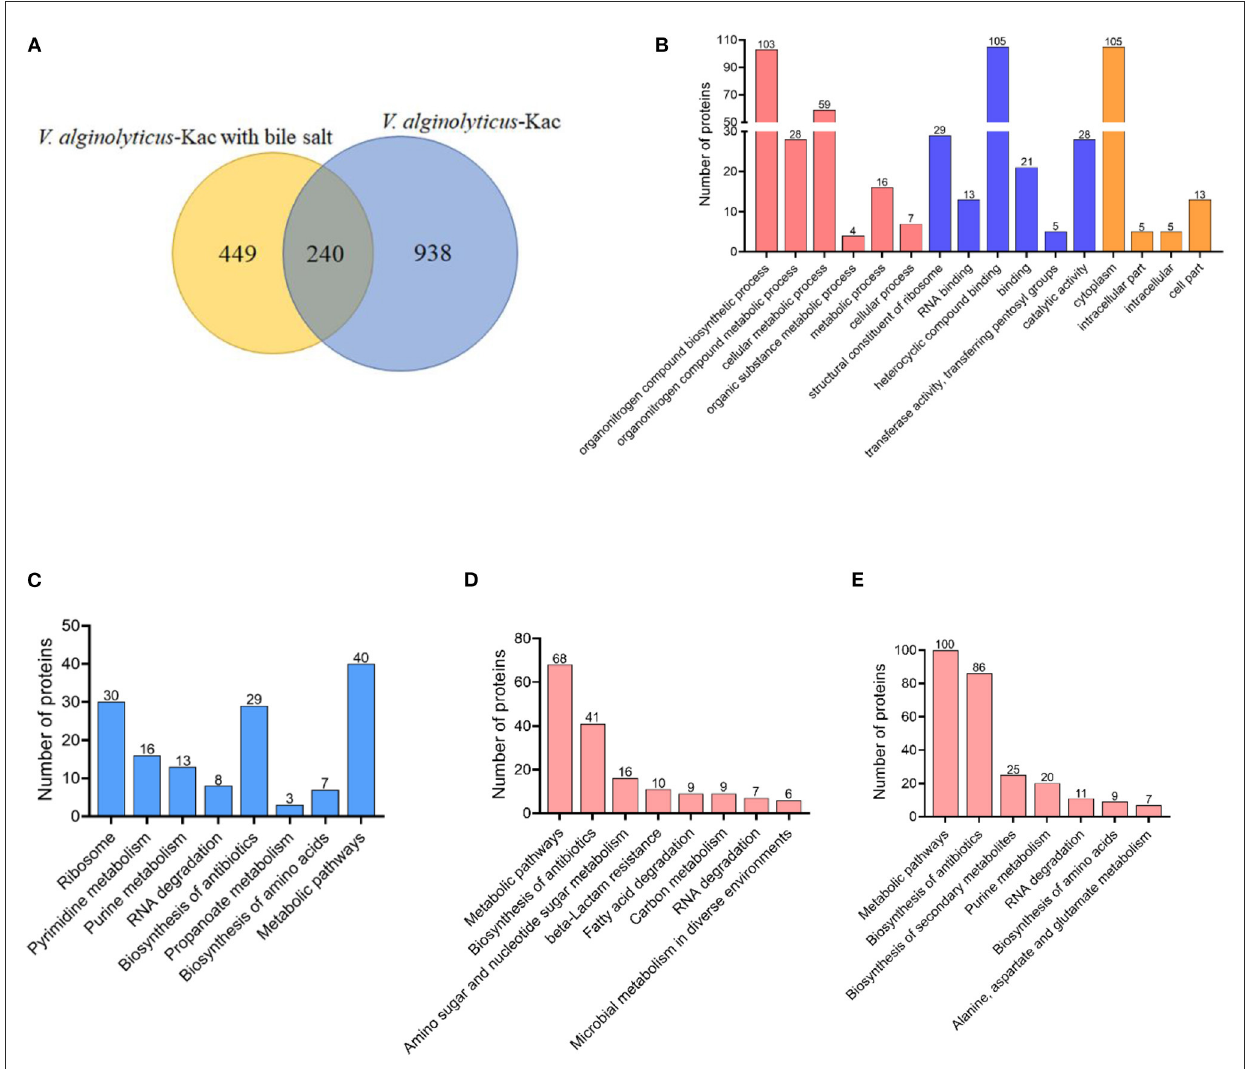
FIGURE7 Comparison of un-treated and treated with bile salt stress lysine acetylated proteins in V. alginolyticus . (A) Overlap between un-treated and treated bile salt stress lysine acetylated proteins in V. alginolyticus , (B) GO enrichment analysis, and (C) KEGG pathway enrichment analysis of the overlapped acetylated proteins. (D, E) KEGG pathway enrichment analysis of treated and un-treated with bile salt stress lysine acetylation